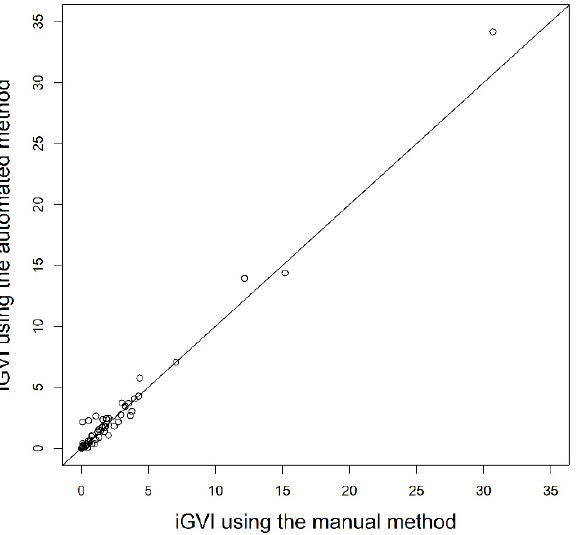
extraction results (iGVI = 13.93%) using K-means clustering algorithm, and ( c ) manual extraction results (iGVI = 12.18%).